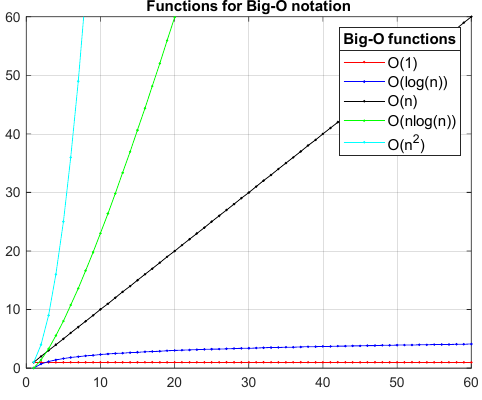
Figure 10. Functions for Big-O Notation.